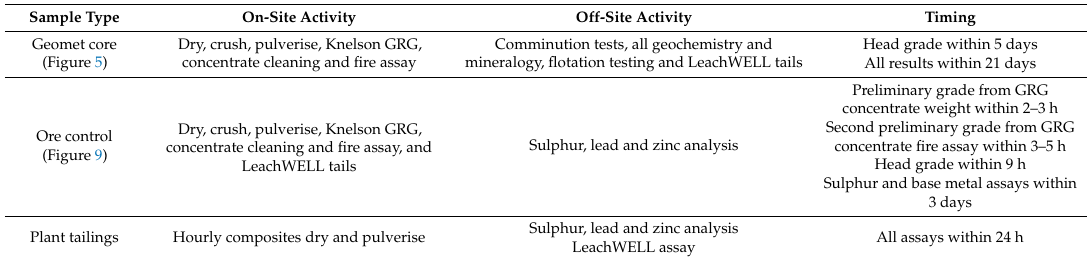
Table 24. Summary of sample processing locations, activity and turn-around times.